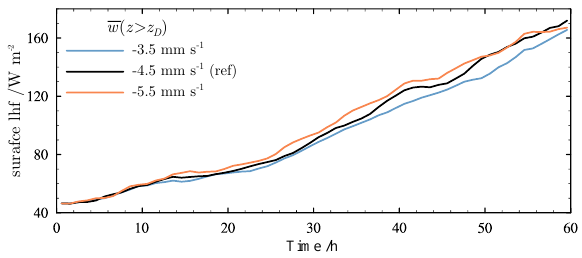
Figure 8. The surface latent heat flux as a function of time for the three sensitivity